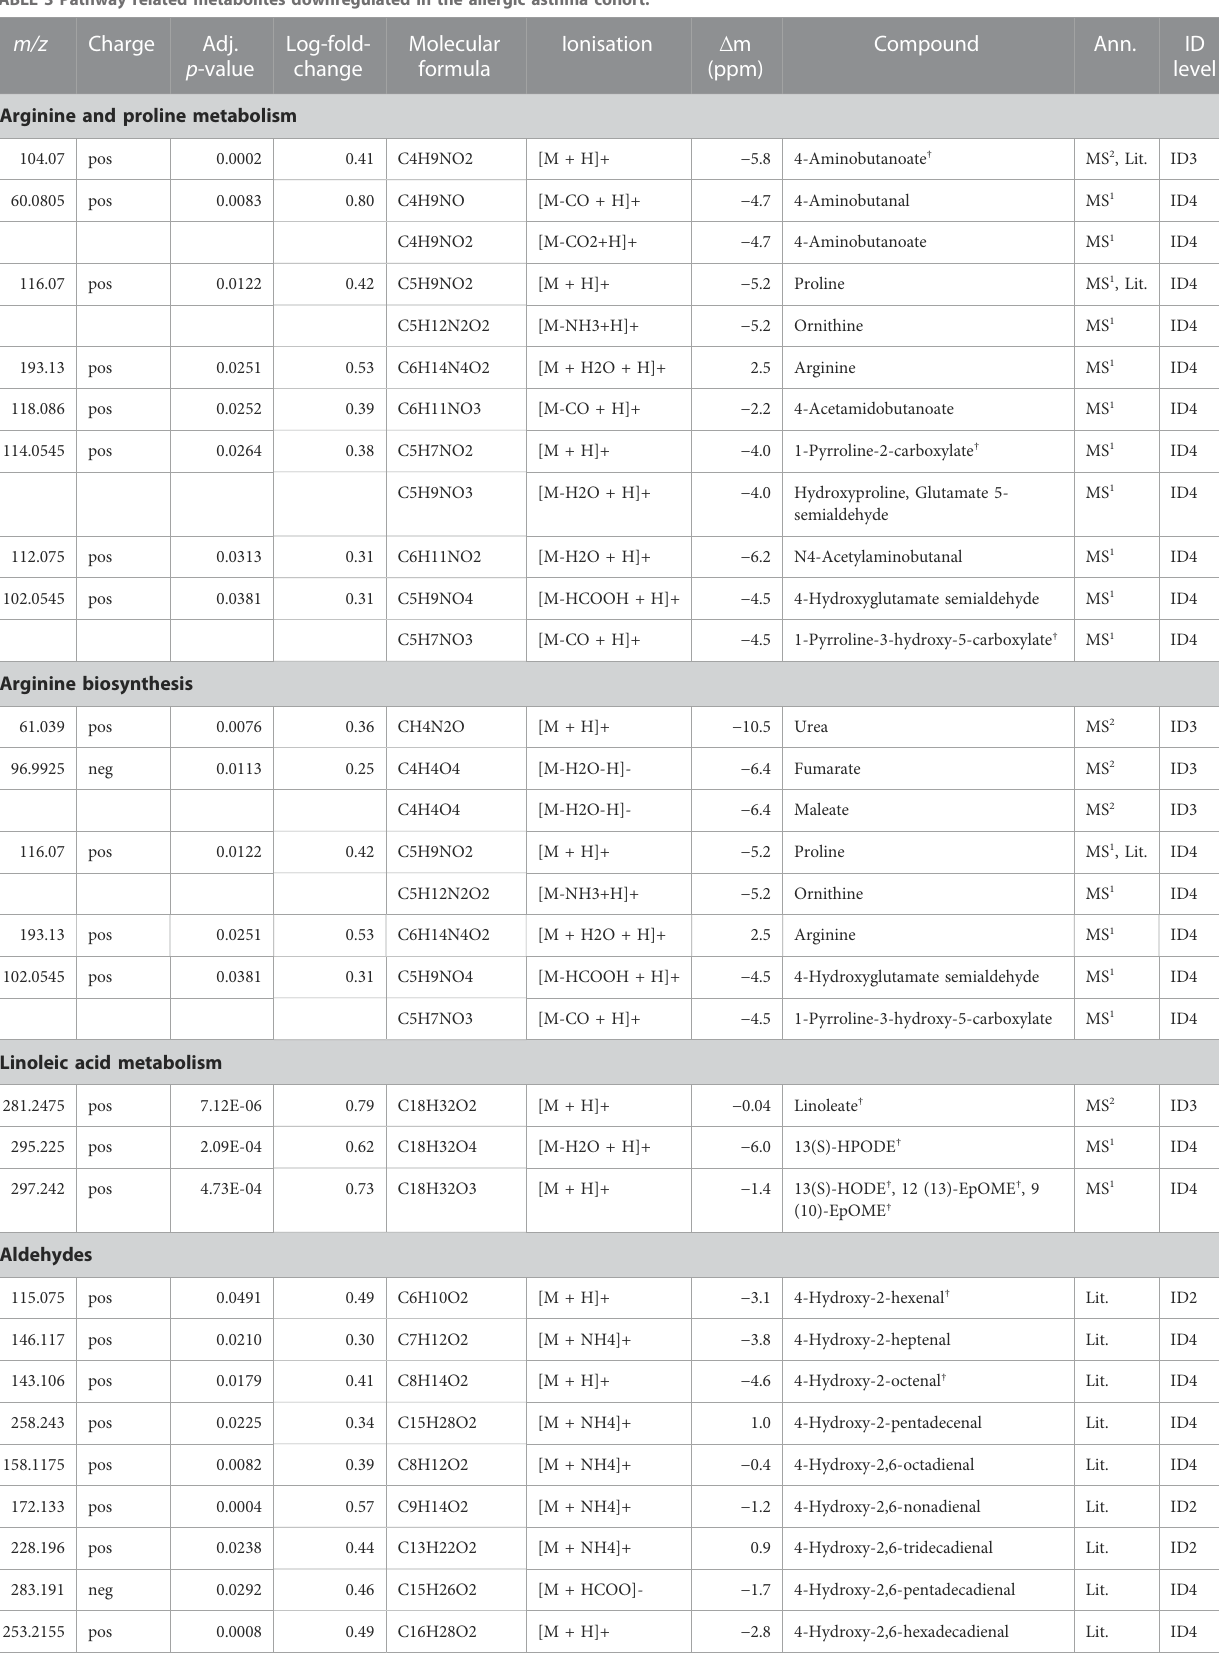
TABLE 3 Pathway related metabolites downregulated in the allergic asthma